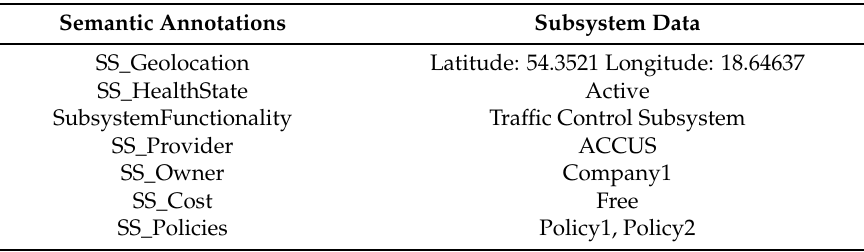
Figure 15. Semantic Subsystem and Service Repository Registration diagram. Table 1. Subsystem data and semantic